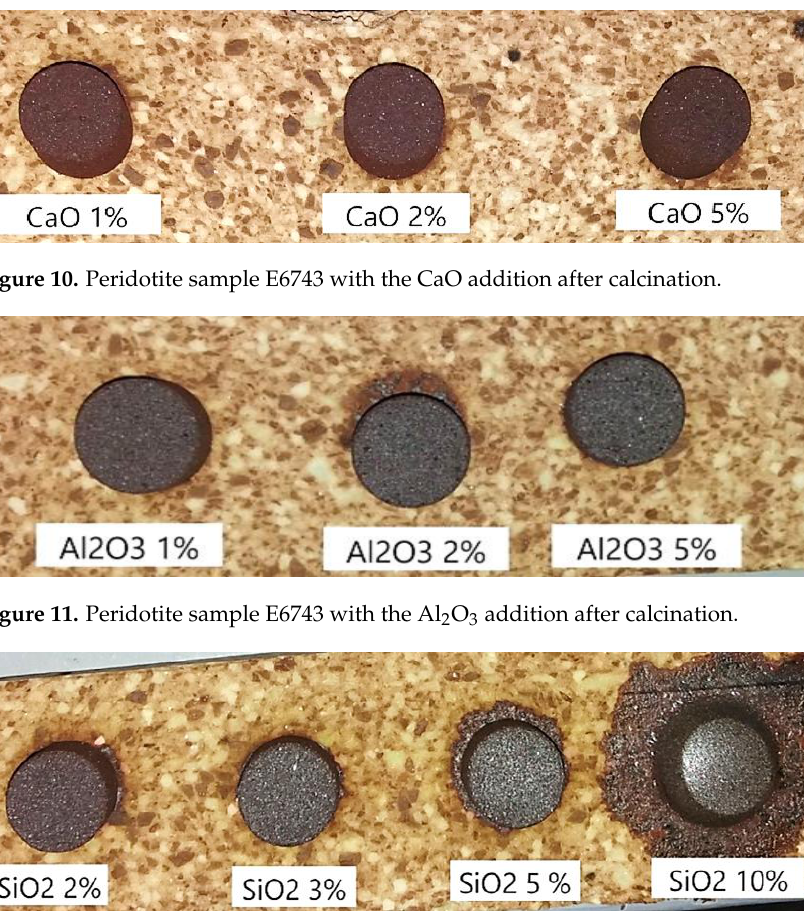
Figure 12. Peridotite sample E6743 with the SiO 2 addition after calcination.